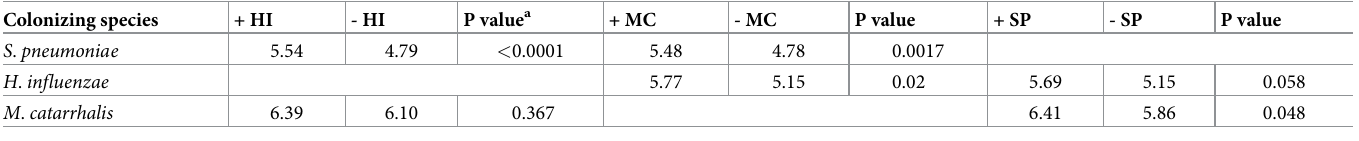
Table 2. Median density in log 10 genome equivalents/ml of pneumococcus (SP), H . influenzae (HI), and M . catarrhalis (MC) when found with (+) or without (-) another species. Colonizing species